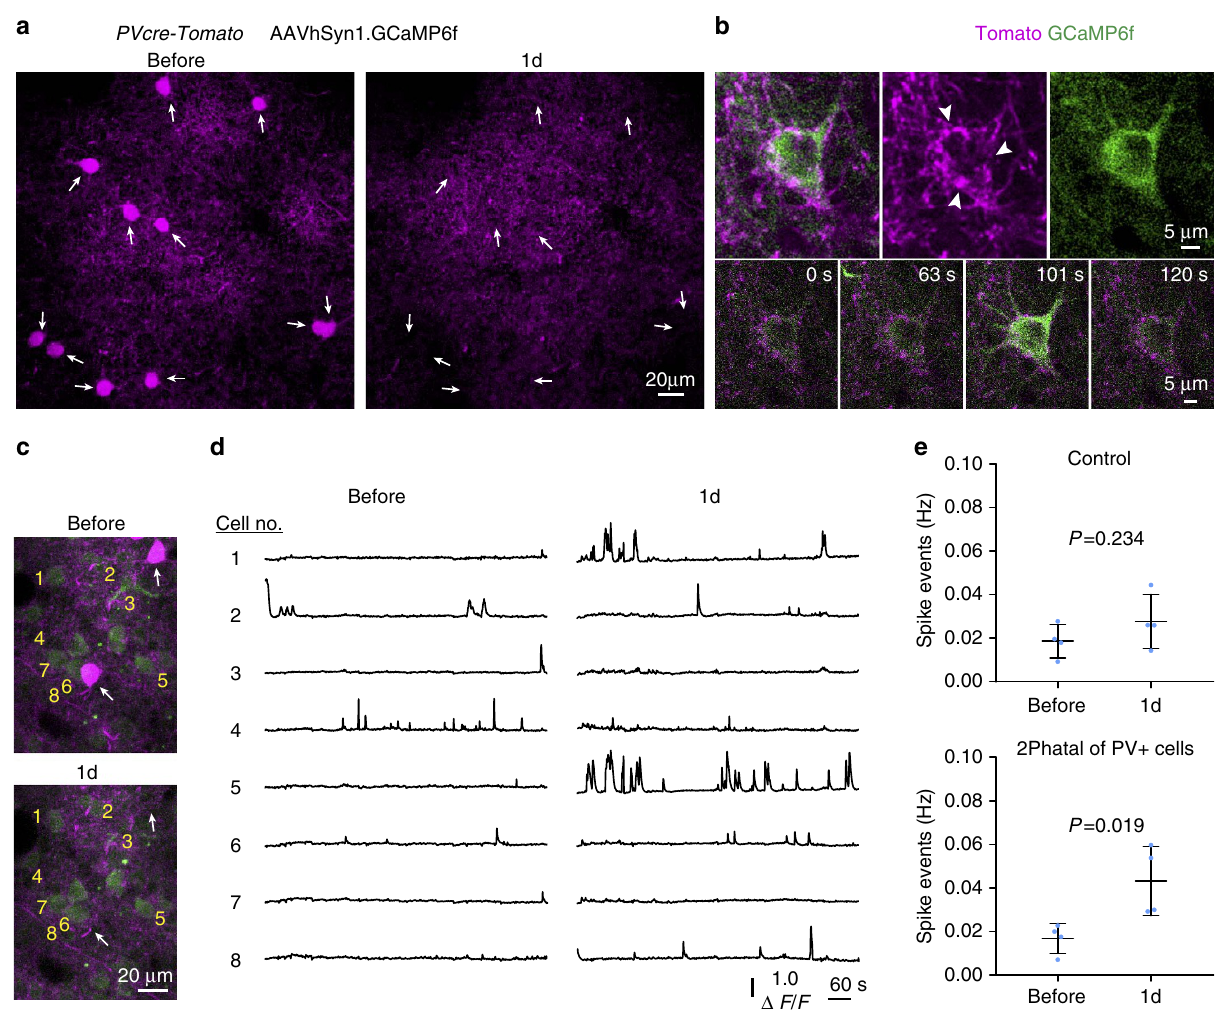
Figure 7 | Disrupted neuronal activity after removal of fast-spiking interneurons. ( a ) In vivo images showing 2Phatal ablation of 11 fast-spiking cortical interneurons (arrows) in a transgenic mouse with tdTomato labelling specifically in PV-expressing neurons ( PV cre-Tomato). ( b ) High-resolution in vivo image (top) and time-lapse sequence (bottom) of a single GCaMP6f AAV viral-labelled neuron with PV cre-Tomato-labelled presynaptic terminals surrounding the cell soma (arrowheads). ( c ) In vivo images showing 2Phatal of single PV þ interneurons (arrows) and location of adjacent GCaMP6f–labelled neurons that were imaged in awake head-fixed mice before and after 2Phatal. ( d ) Spontaneous GCaMP6s fluorescence intensity traces from awake head-fixed mice taken from the numbered cells indicated in ( c ) before and 1 day after 2Phatal of PV þ interneurons. ( e ) The spontaneous frequency of calcium transients in control regions with no cells ablated or after 2Phatal of 8–11 PV þ interneurons within the local area. Significance determined by paired t -tests, control P ¼ 0.234, t ¼ 1.485, df ¼ 3, 2Phatal, P ¼ 0.019, t ¼ 4.677, df ¼ 3, as indicated, n ¼ 4 mice (62 cells in control group, 67 cells in 2Phatal group) (df ¼ degrees of